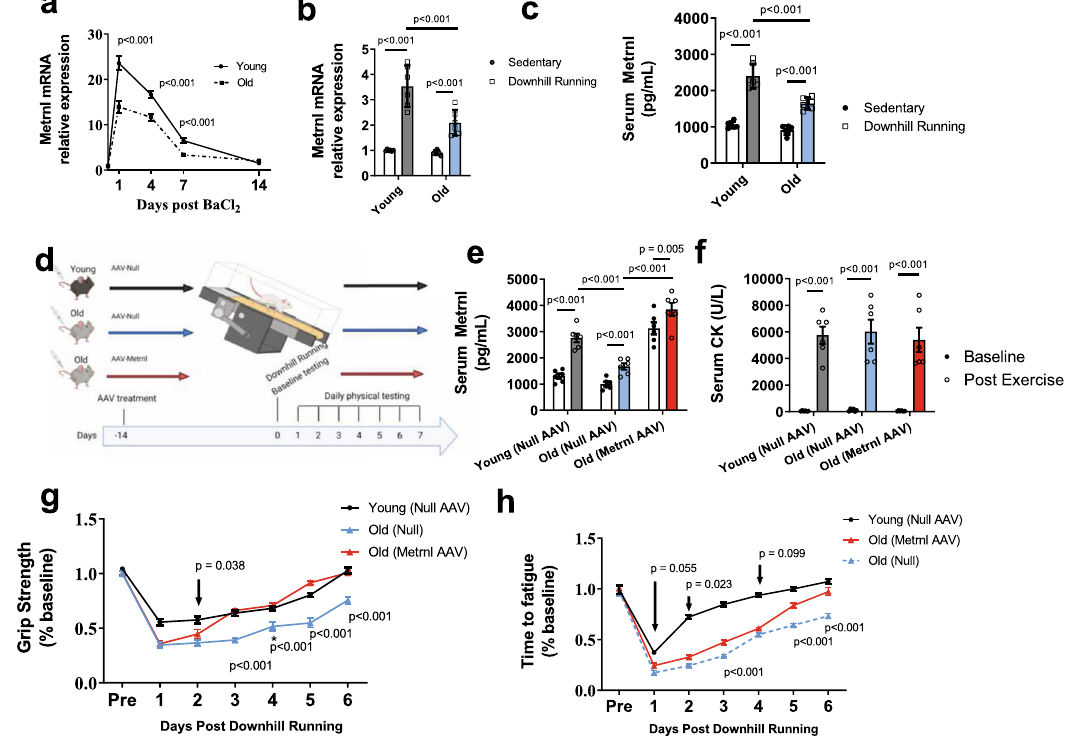
Fig. 1 | Meteorin-like expression is reduced in aged muscle regeneration. a Metrnl mRNA measured by qPCR from mouse TA muscles following BaCl 2 - induced muscle damage ( n =6 independent animals/age/timepoint); two-tailed t test was used to compare young to old at each timepoint. b Metrnl mRNA and c plasma protein in young and old mice 24h following downhill running-induced muscle damage ( n =6 independent animals/group); 2×2 ANOVA was used with Fisher ’ sLSDposthocanalysis. d Graphicrepresentationofmousedownhillrunning experiments. e CirculatingMETRNLbeforeandat24hpostdownhillrunning( n =6 independent animals/group); 2×3 ANOVA was used with Fisher ’ s LSD post hoc